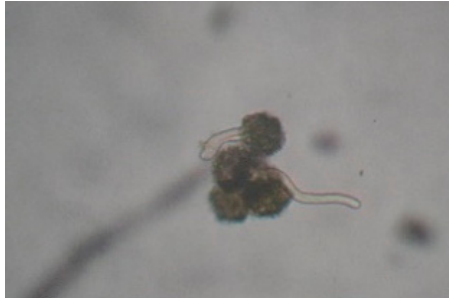
Figure 4. Dryopteris filix-mas —germinated spores: HA 1:10 variant, ×100.